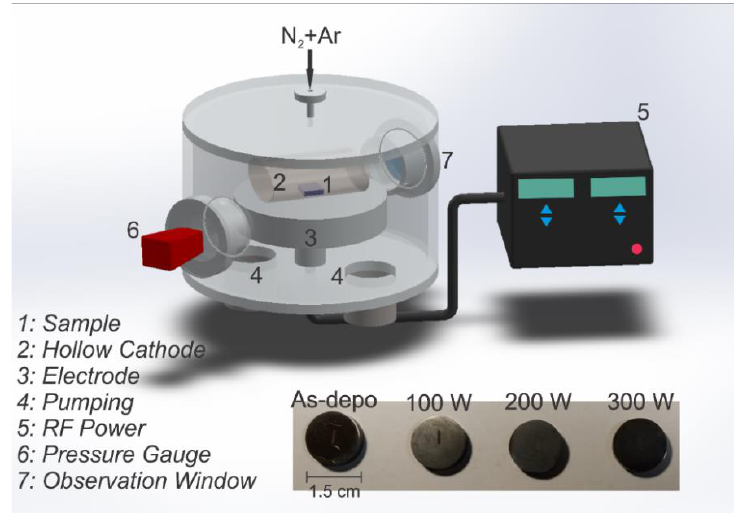
Figure 1. Schematic diagram of the reactor and photographs of the samples as deposited and treated for 10 min in an N 2 atmosphere under powers of 100 W, 200 W, and 300 W.